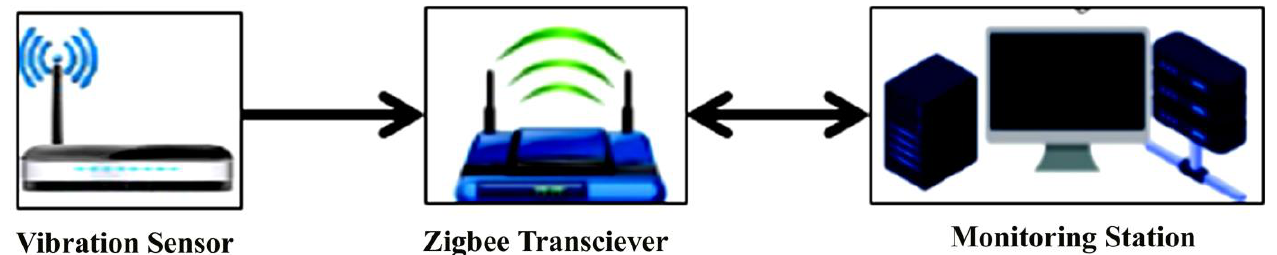
Figure 7. Actual set-up of nodes in IoT.